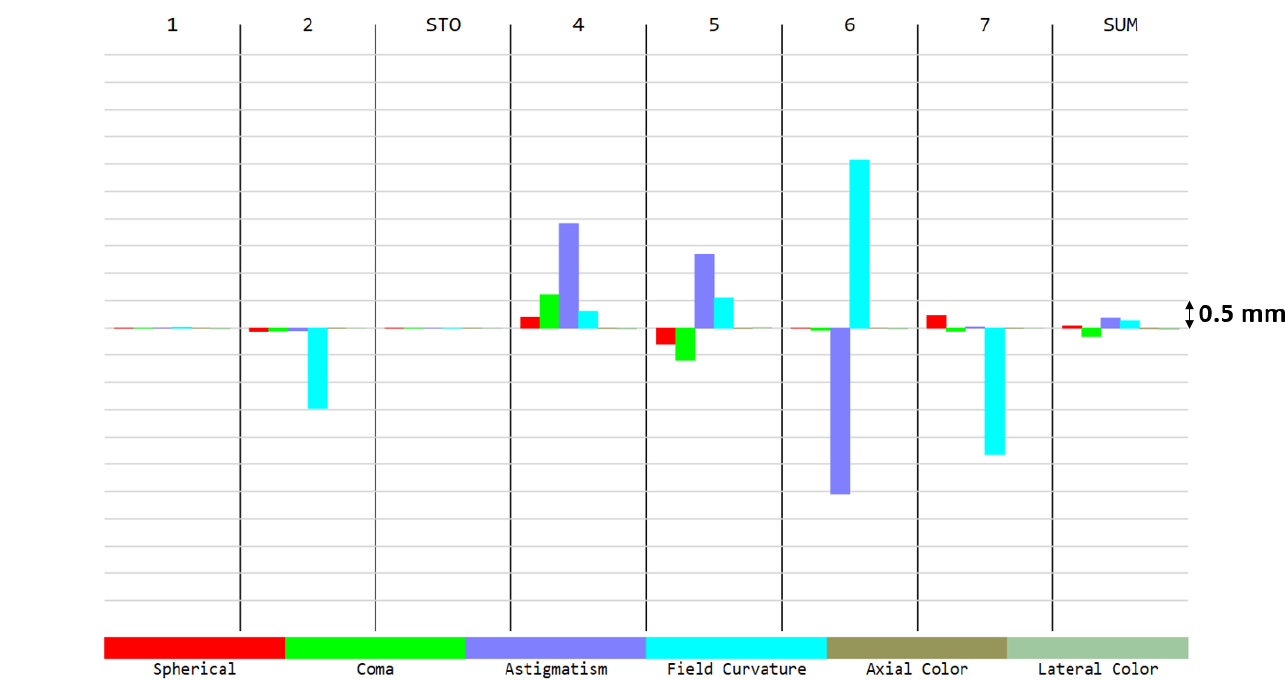
Figure 3. Seidel aberrations and (axial and lateral) chromatic aberrations, except for distortion. The aberrations are given for each surface involved in the optical system (1 and 2 for the first lens, 3 = STO i.e., the stop aperture, 4 and 5 for the second lens, 6 and 7 for the third lens). The SUM represents the sum of these aberrations at the image plane. All these aberrations are corrected. The same aberration contributions were observed for all wavelengths between 8 and 14 µ